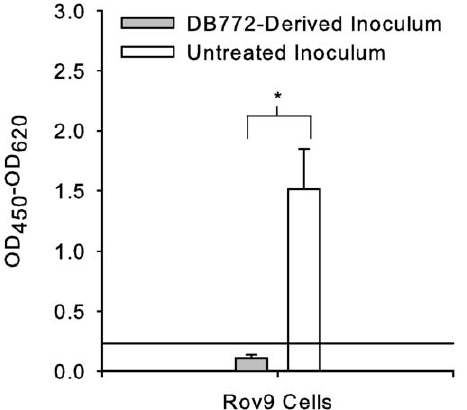
Figure 4. DB772 inhibits prion infectivity in Rov9 cells. Rov9 Sc/ DB772 and Rov9 Sc/UnTx cells were mechanically lysed and used as prion inoculum. Rov9 cells inoculated with these new inocula were then tested for PrP Sc via ELISA. Data columns represent the corrected optical density (OD 450 – OD 620 , per manufacturer’s instructions to correct for nonspecific optical density) means 6 one standard deviation of three independent experiments, each run in triplicate. The y-axis reference line indicates the minimum detection limit of the ELISA. *, P , 0.001.